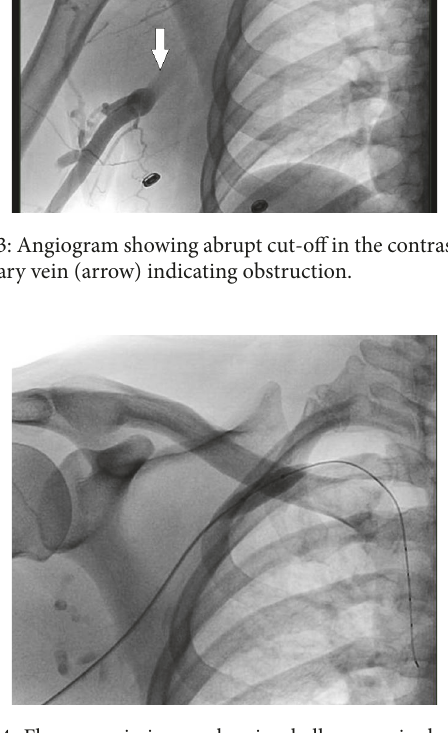
Figure 4: Fluoroscopic image showing balloon angioplasty being performed.